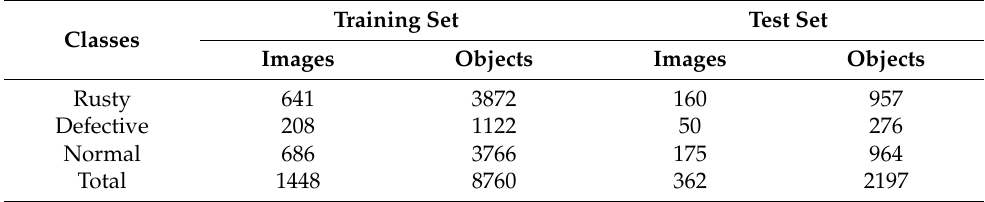
Table 1. Sample distribution for different classes in